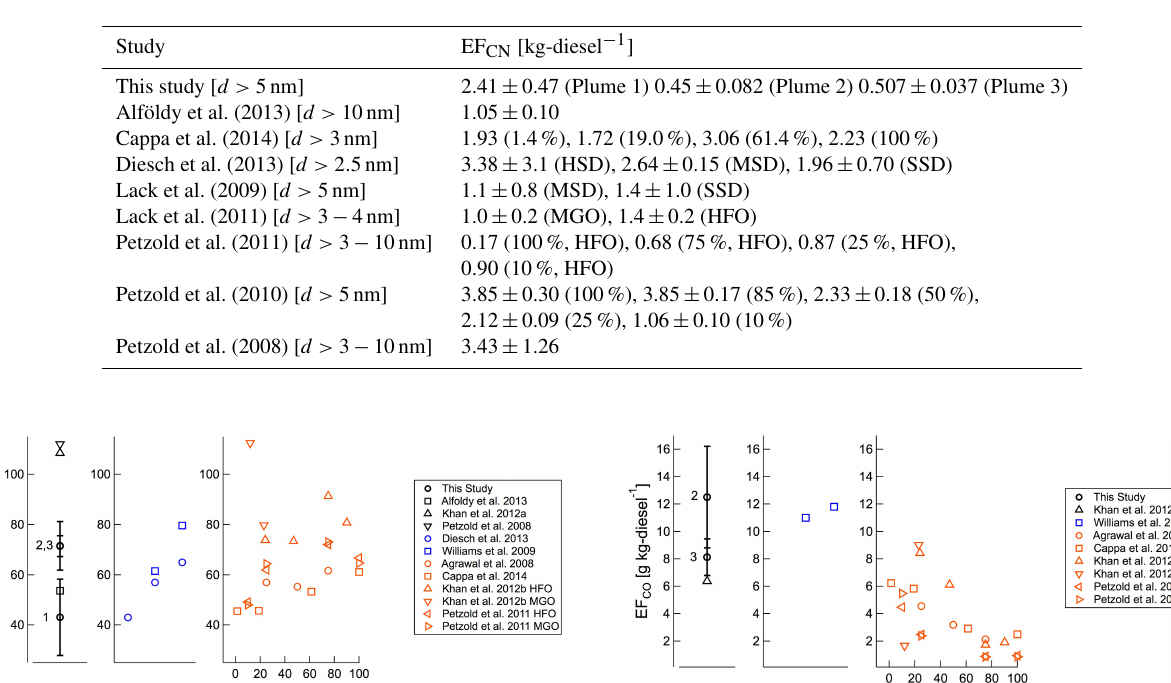
Table 6. Emission factors for total particle count × 10 16 ; numbers in brackets indicate engine load (%), fuel type (HFO: heavy fuel oil with high sulfur content, and MGO: marine gas oil with low sulfur content), or vessel class based on gross metric tonnage (HSD: high speed diesel < 5000t, MSD: medium speed diesel 5000–30000t, or SSD: slow speed diesel > 50000t); the uncertainty is computed using the orthogonal distance regression (ODR) method.